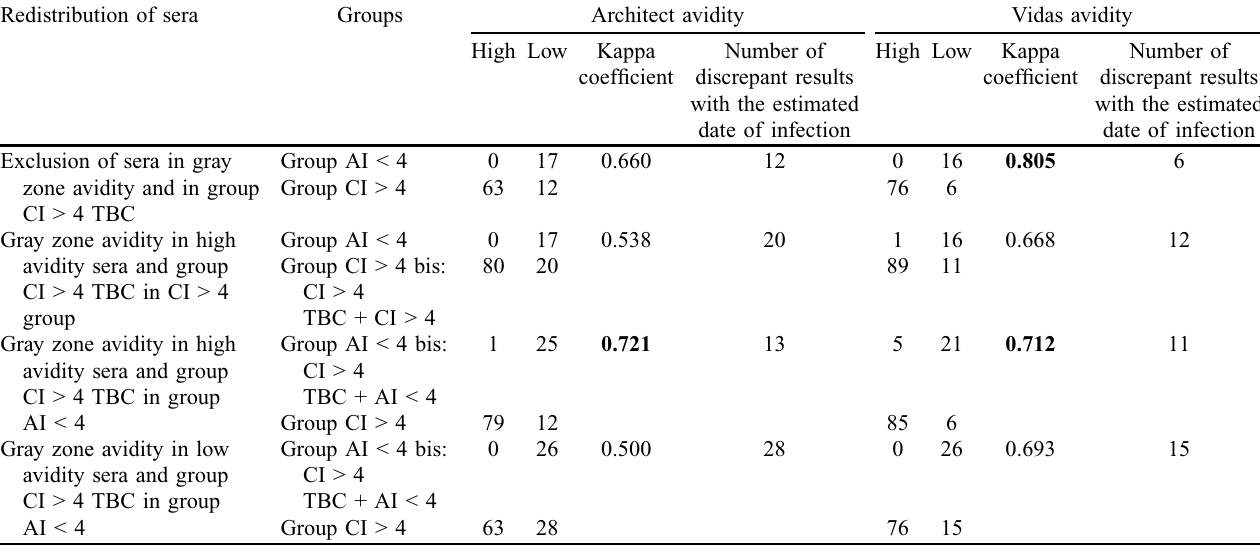
Table 2. Agreements between avidity tests results and estimated date of infection after redistribution of sera with values in the gray zone and belonging to group CI > 4